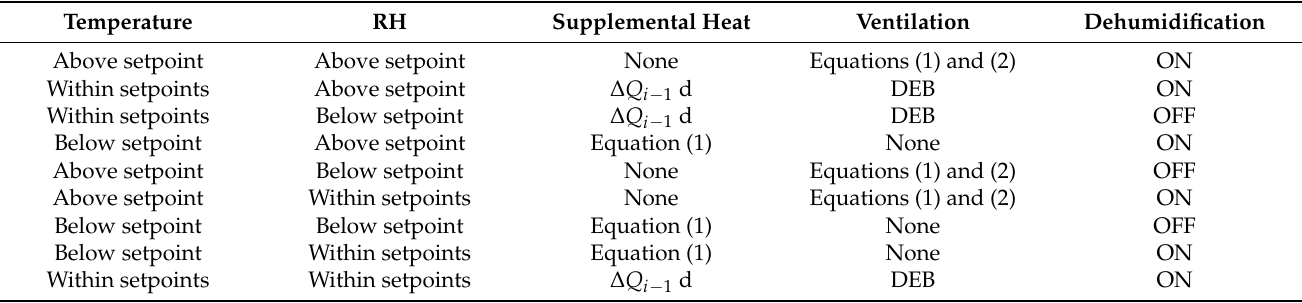
Table 3. Controller logic with dehumidifier in use.